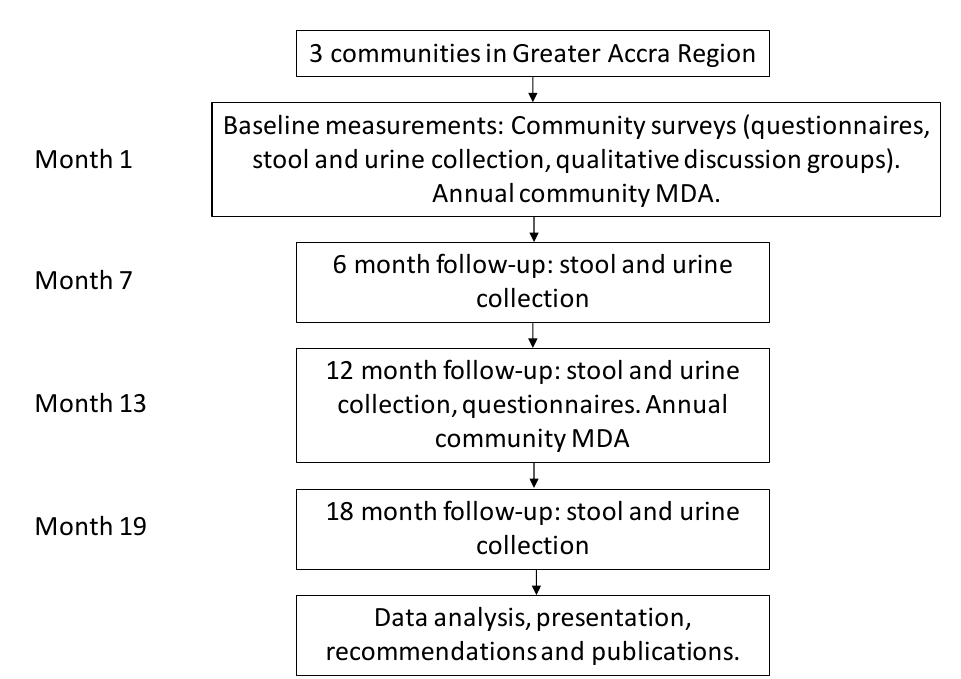
Figure 2. Diagram showing the study design of the expanded treatment intervention survey.